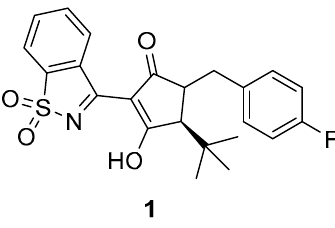
Figure 1. Structure of a benzo[ d ]isothiazole-1,1-dioxide 1 .